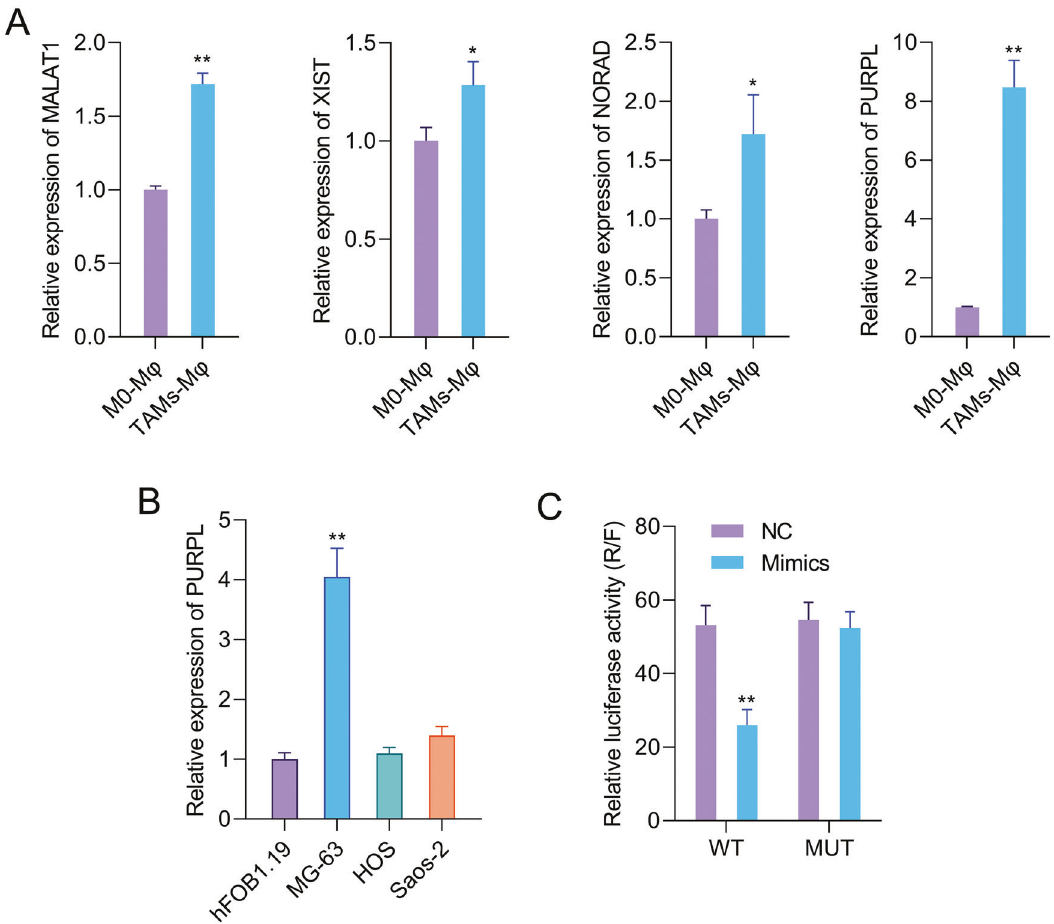
Fig. 2 TAMs upregulated the expression of several lncRNAs in MG-63 cells. A TAMs were cultivated into the upper- chamber, while MG-63 cells were put into the lower- chamber. Forty-eight hours later, the expression of MALAT1, XIST, NORAD, and PURPL in MG-63 cells were tested via qPCR. B qPCR was used to test PURPL expression in hFOB1.19, MG-63, HOS, and Saos-2 cells. C MG-63 cells were subjected to miR-363 mimics and PURPL-WT (or PURPL-MUT) transfection. The relative luciferase activity (R/F) was detected. *P < 0.05, **P < 0.01 vs . hFOB1.19, M0- M φ , or NC